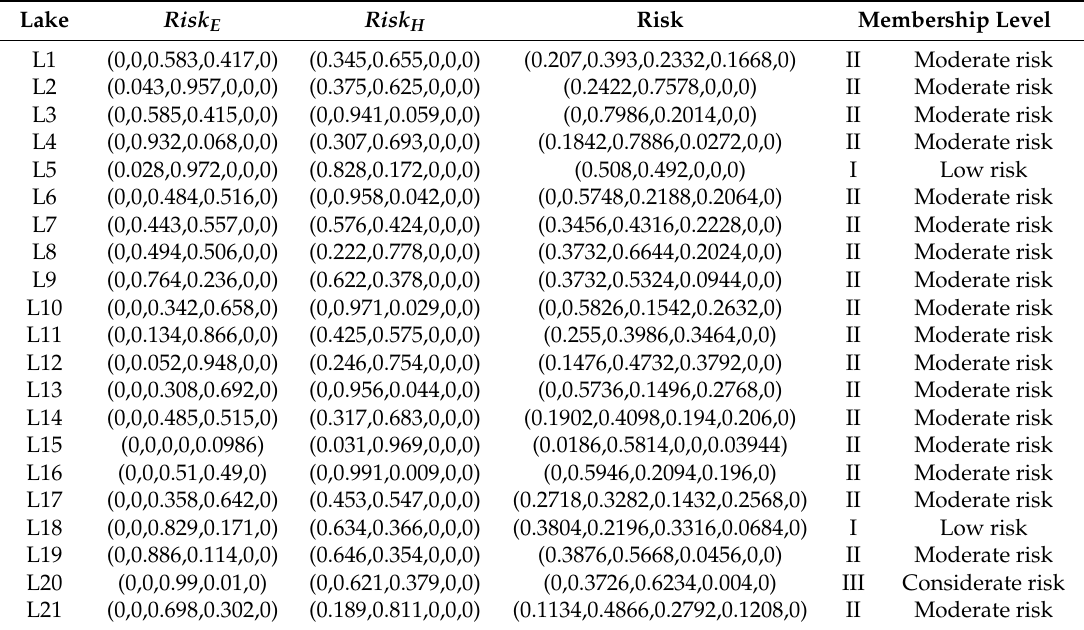
Table 5. The fuzzy matrix of Risk E and Risk H